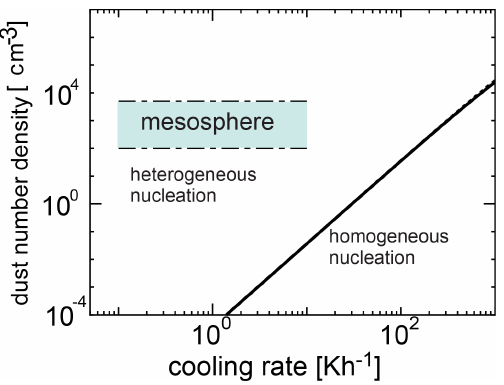
Figure 6. The condition of the number density of dust grains (ver- tical axis) and the cooling rate (horizontal axis) required for the heterogeneous nucleation at an initial temperature of 135K. Solid and dotted lines represent λ = 2 . 5 and λ = 3 . 5, respectively.